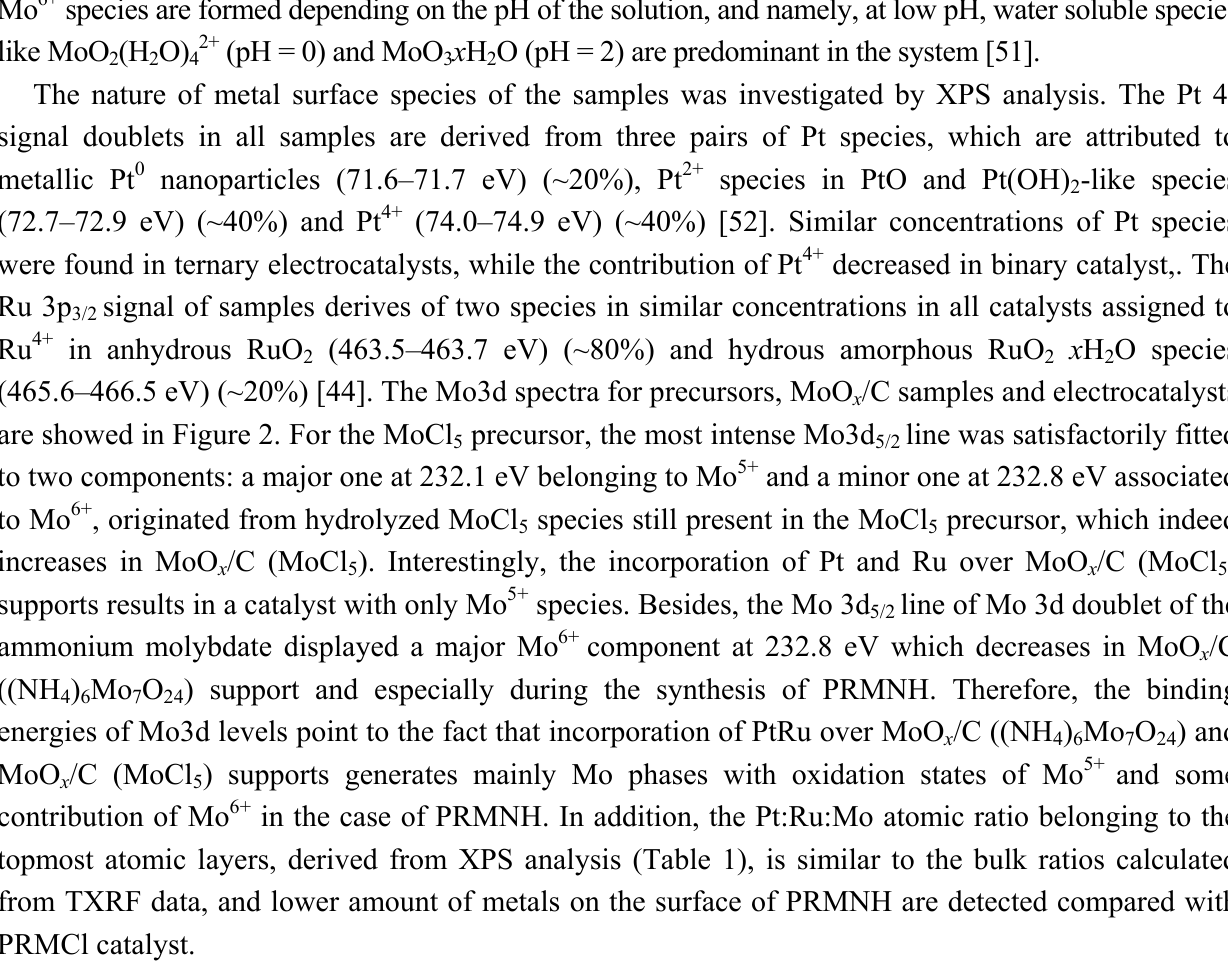
core-level spectra of precursor ( A ); supports ( B ) and electrocatalysts ( C ). Figure 2. Mo 3d Adapted from Tsiouvaras et al.